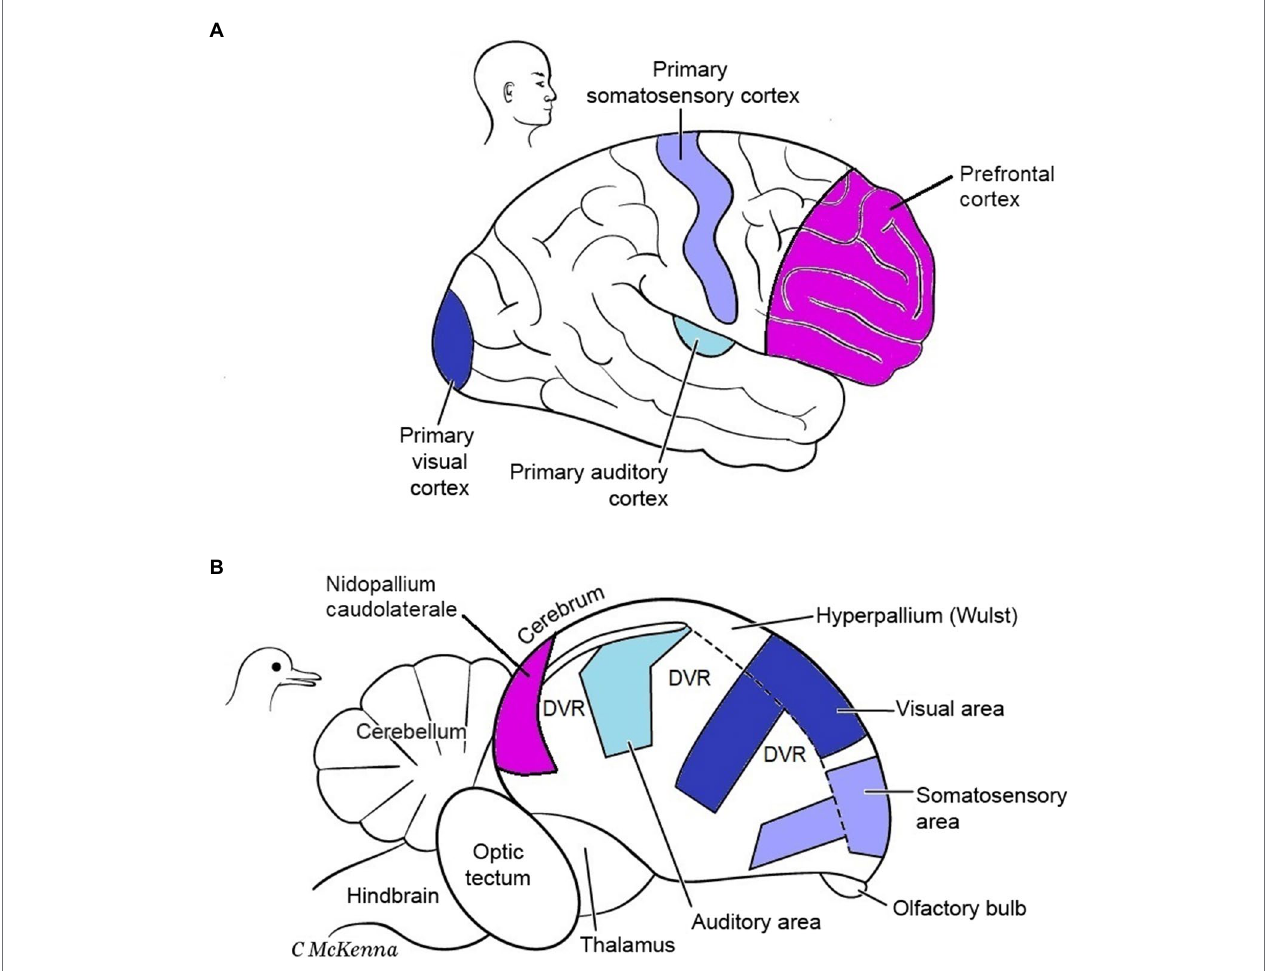
FIGURE 8 | Cerebrums of a mammal (A) and bird (B) . Functional areas involved in conscious sensory perception and cognition are color-coded. The same functional areas have evolved in different relative locations in these brains. DVR, dorsal ventricular ridge of bird. Modified from Figure 6.9 in Feinberg and Mallatt (2016). The images are reproduced with the permission of the copyright holder Mount Sinai Health